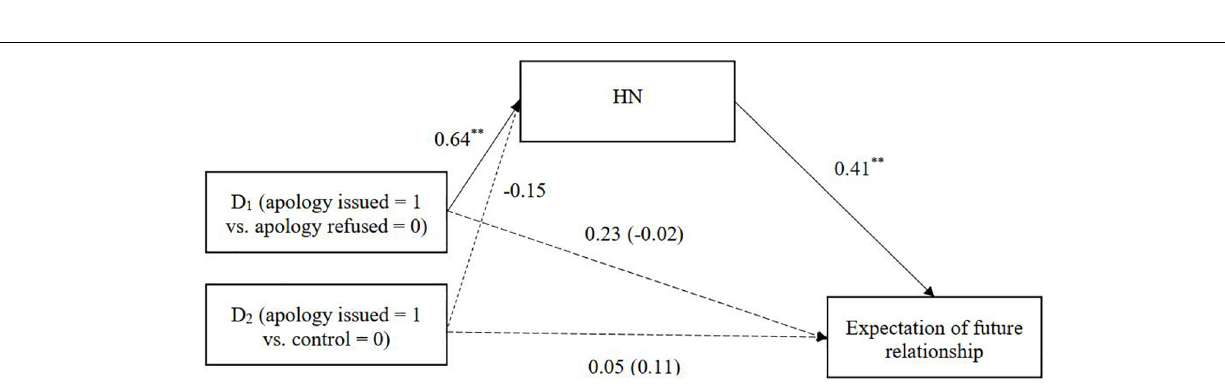
FIGURE 3 | HN mediating the relationship between condition and expectation of a future relationship (Study 1). Unstandardized coefficients are presented. Coefficients in parentheses denote direct effects after controlling for indirect effects. ∗∗ p < 0.01.